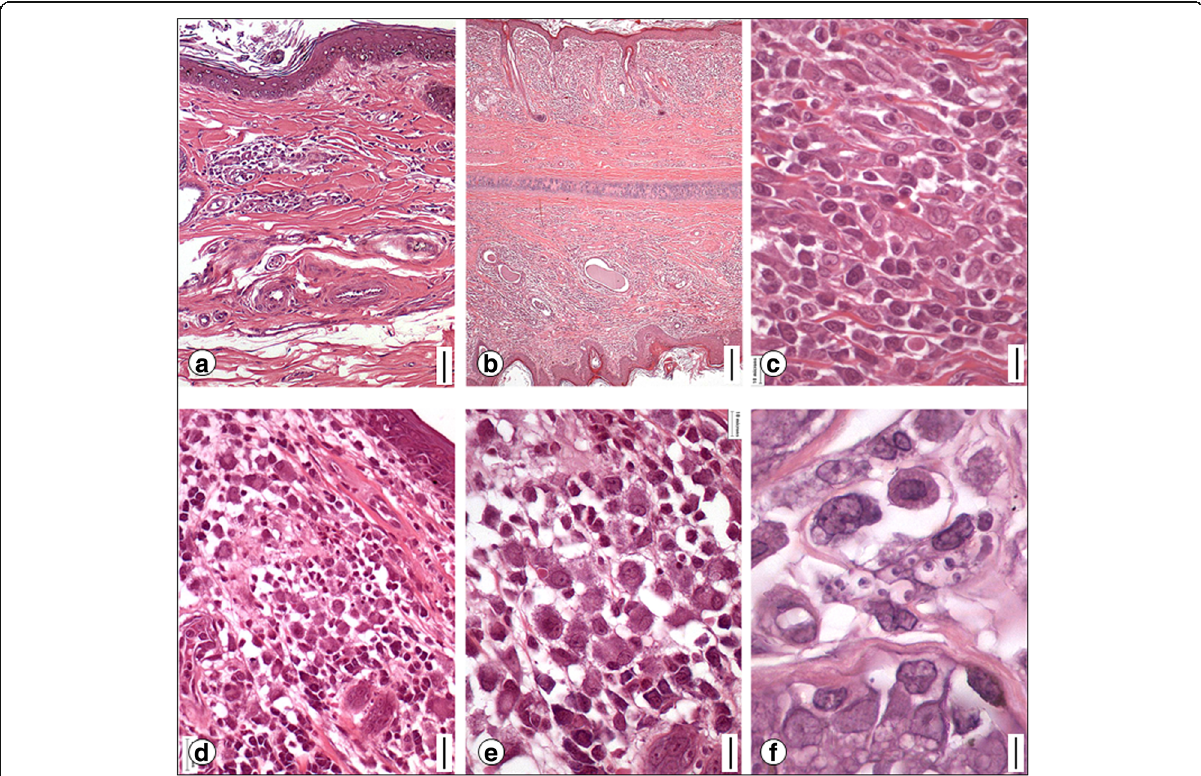
Fig. 1 Histological patterns of dermatitis present in dogs from an endemic area of visceral leishmaniasis: a focal dermatitis; b diffuse dermatitis; c inflammatory infiltrate with a predominance of plasma cell and macrophages; d inflammatory infiltrate with granulomatoid area; e a granuloma in detail; and f – amastigote-loaded macrophage in the dermis. Lengths of the black bars on the right hand side at the bottom of the figures: a ,